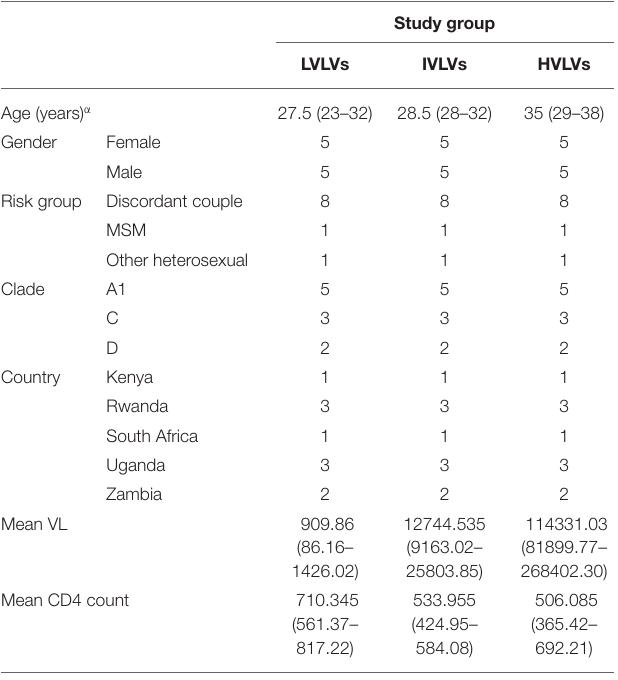
TABLE 1 | Characteristics of groups selected from the HIV incidence